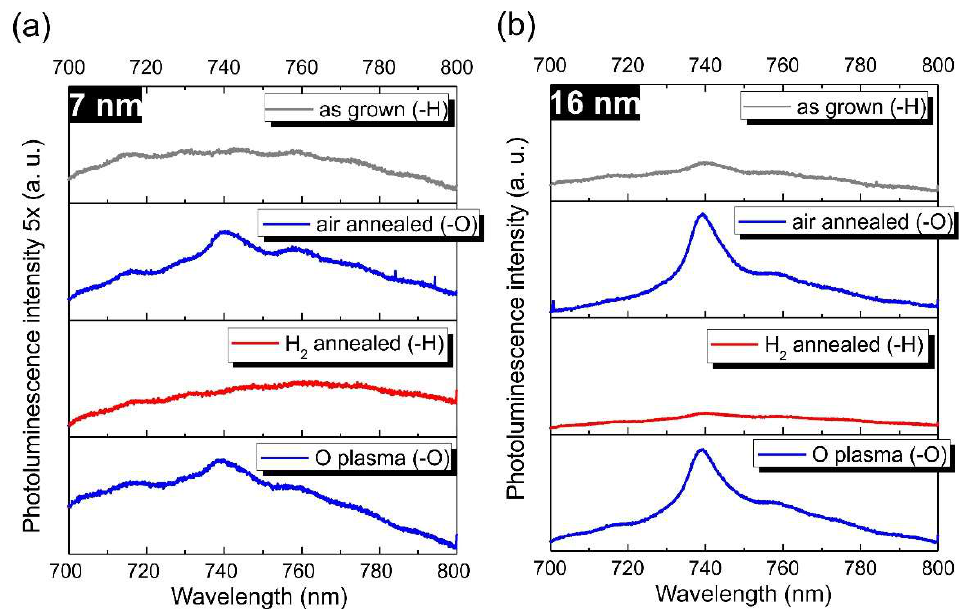
Figure 5. SiV PL data of 7 nm ( a ) and 16 nm ( b ) NCD2 films in dependence on the surface chemistry variation. The specific treatments are mentioned in the legends for clarity.